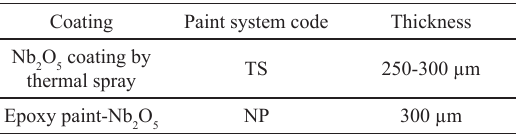
Table 1. Coating system applied to carbon steel.